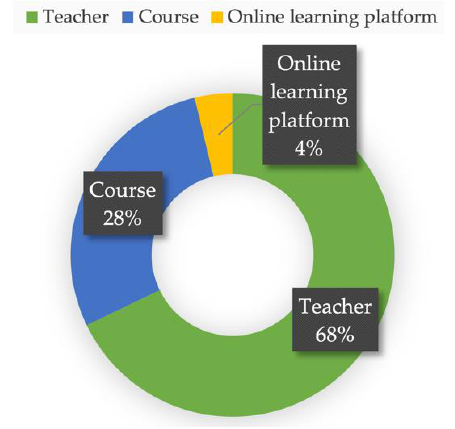
Figure 6. Tagged data distribution picture of aspect categories.